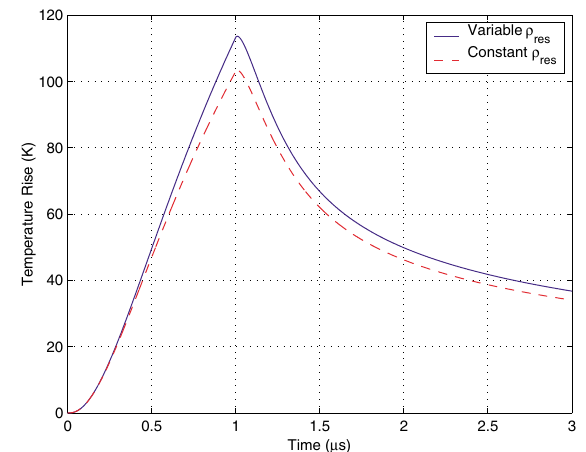
FIG. 12. (Color) Comparison of variable (cid:16) on the temperature rise of the cavity end caps for a 10 MW, 1 (cid:3) s pulse.